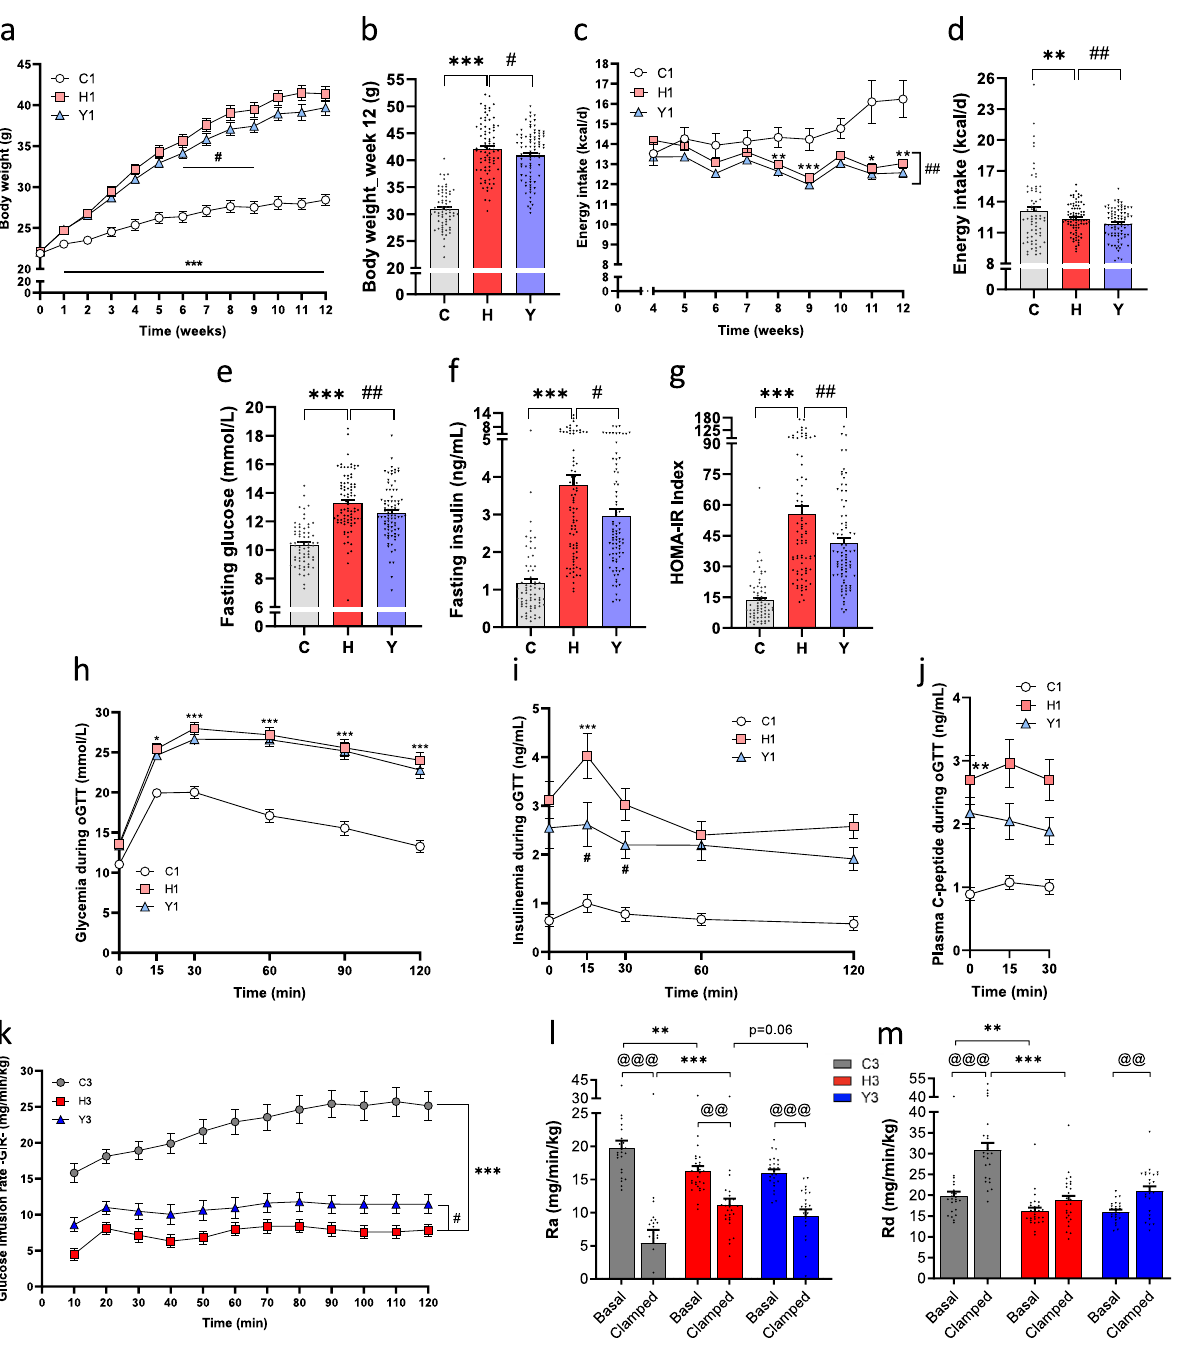
Fig. 1 Yogurt consumption preserves glucose homeostasis and insulin sensitivity. Metabolic results of mice in the three studies (see also Supplementary Fig. 1 for the experimental design, Supplementary Data 1 and Supplementary Fig. 2). a Body weight throughout the Study 1. b Pooled analysis of the three studies showing mice fi nal body weight after 12 weeks of dietary treatment. c Energy intake was recorded from week 4 to week 12 in Study 1. d Pooled analysis of the three studies showing mice daily energy intake. e – g Pooled analysis of fasting glucose, insulin, and corresponding HOMA-IR index after 12 weeks of treatment. h Glucose tolerance test at week 11 in Study 1. i Insulin response following the oral glucose challenge in Study 1. j C-peptide response following the oral glucose challenge in Study 1. k – m In Study 3, mice underwent an hyperinsulinemic-euglycemic clamp at week 12. k Glucose infusion rate (GIR). l Glucose rate of appearance (Ra) depicting hepatic glucose production. m Whole-body glucose rate disappearance (Rd) depicting glucose disposal. Data are expressed as mean ± SEM. Study 1: n = 18 – 24 except for panel ( i ) ( n = 9 – 12) and ( j ) ( n = 6 – 10); Study 3: n = 23 – 27; Pooled analysis: n = 66 – 84 biologically independent mice. H versus C: * p < 0.05, ** p < 0.01, *** p < 0.001. Y versus H: # p < 0.05, ## p < 0.01. For clamps data, basal versus clamped condition: @@ p < 0.01, @@@ p < 0.001. C: low-fat low-sucrose control diet (C: soft gray, C1: white, C3: gray); H: high-fat high-sucrose diet with a protein mixture replacing casein (H: soft red, H1: pink, H3: red); Y: lyophilized yogurt incorporated in H diet (Y: soft blue, Y1: light blue, Y3: blue). Numbers (1, 2, 3) refer to the study af fi liation. Two-way repeated-measures ANOVA or Mann – Whitney tests depending on data distributions with ( a , h – j ) or without ( b – g , k – m ) baseline adjustment. T -test at baseline ( j ). All tests were